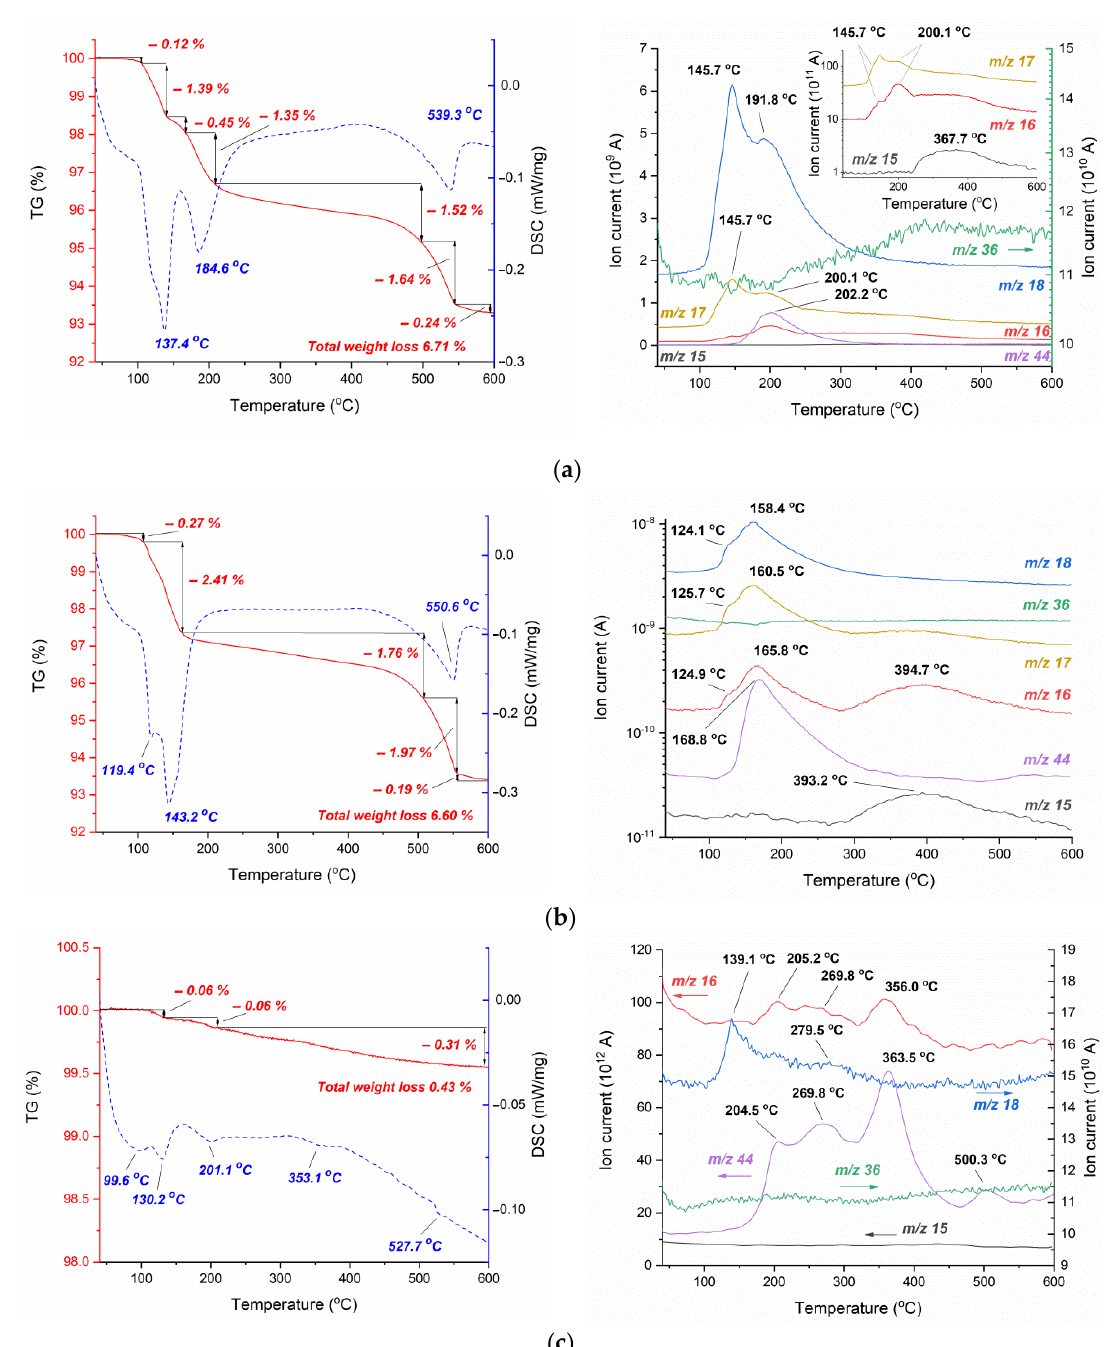
Figure 7. TGA/DSC (left) and MS (right) curves for ZnO@AmCl(3%): ( a ) TVTZnO@AmCl(3%); ( b ) CSTVTZnO@AmCl(3%); and ( c ) samples. In TG/DSC graphs: red—TG curves; blue lines—DSC curves. In MS graphs, colored lines corresponded to the indicated m/z values.